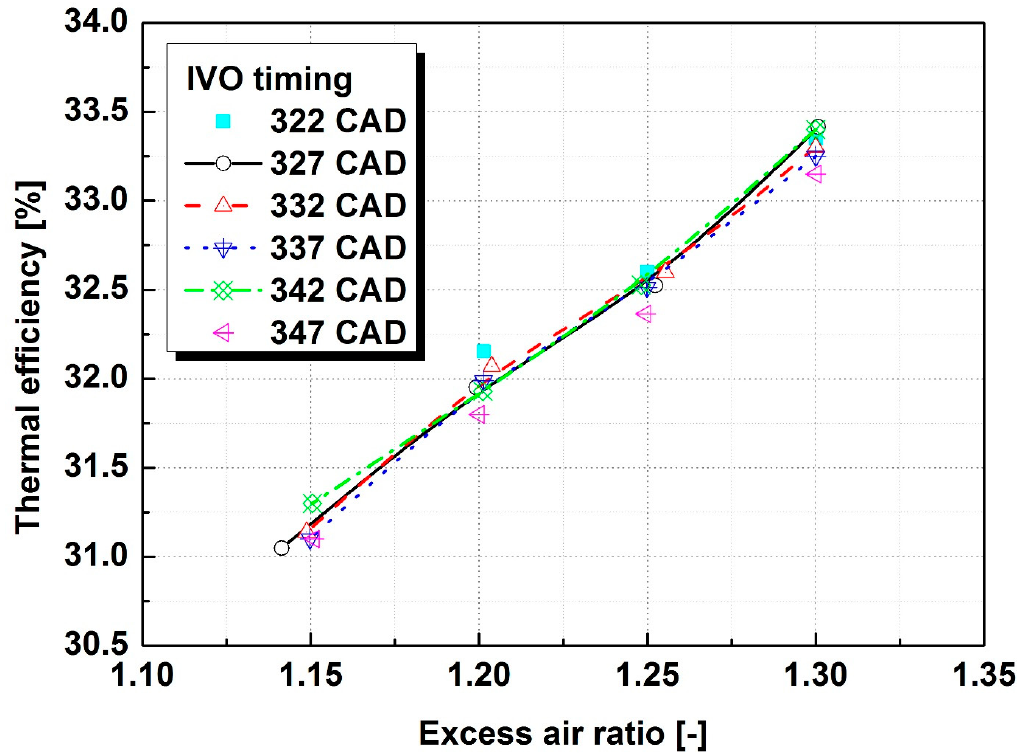
Figure 9. Thermal efficiency changes with intake valve opening time and excess air ratio changes at constant exhaust valve opening time of 161 CAD